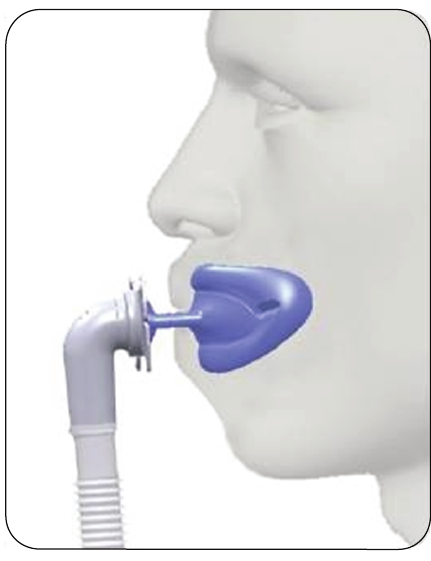
Figure 1: SomnuSeal